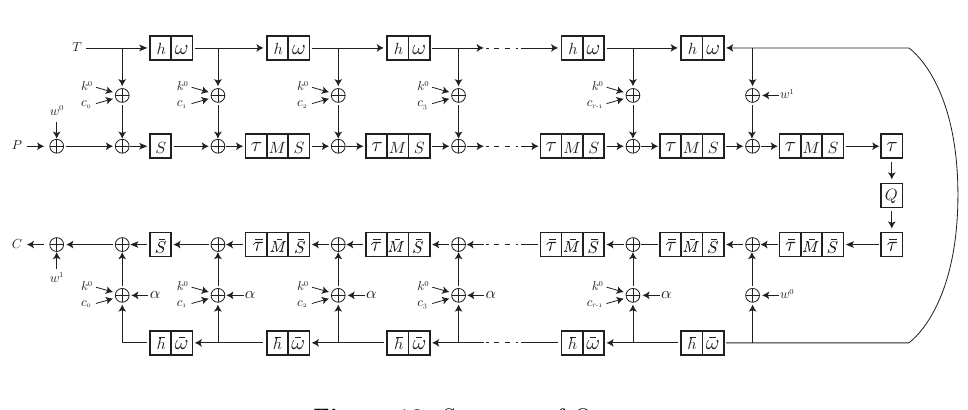
Figure 13: Structure of Qarma .